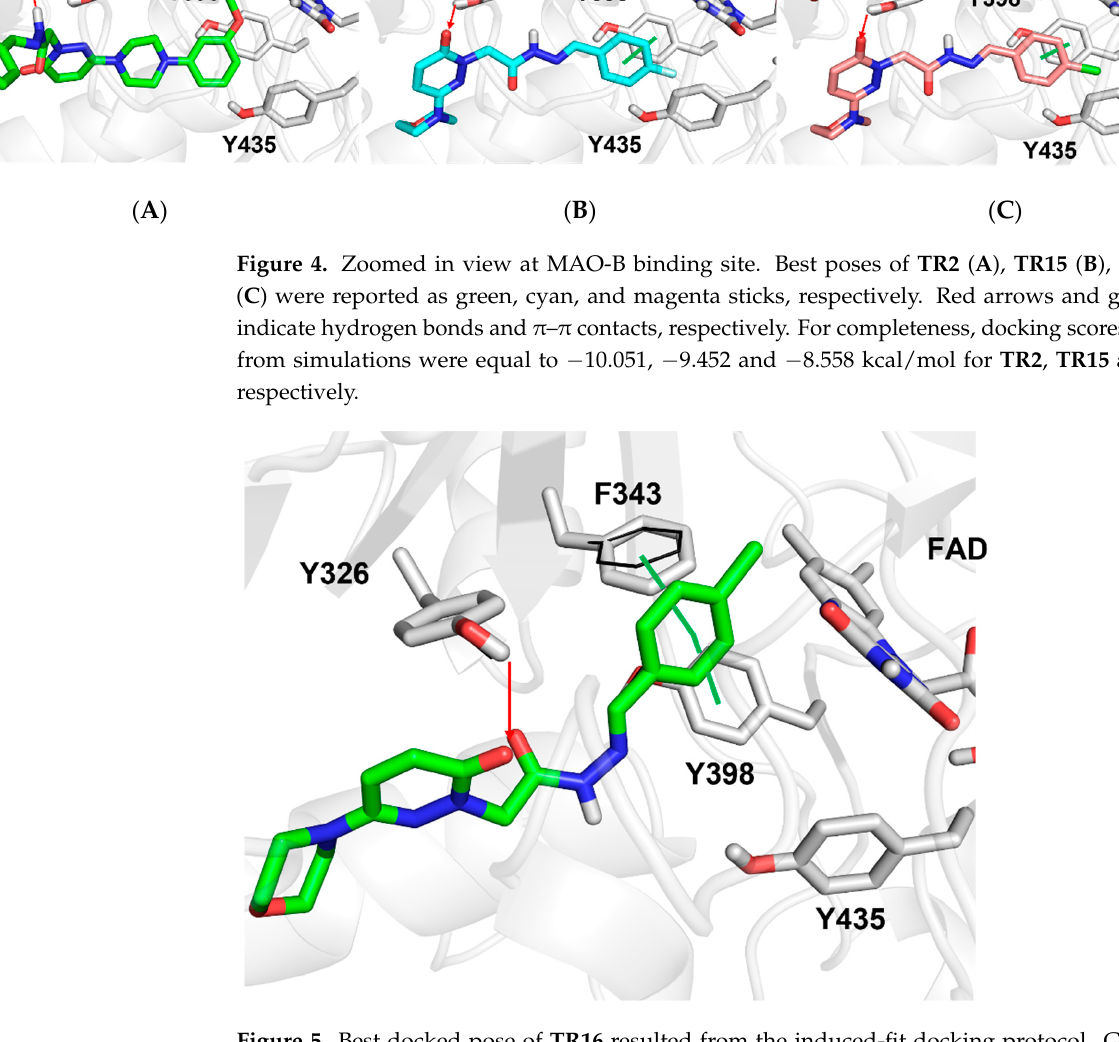
Figure 5. Best docked pose of TR16 resulted from the induced-fit docking protocol. Green lines and red arrows depict π – π contacts and hydrogen bonds, respectively. Black lines show the original conformation of MAO-B sidechains. For completeness, docking score was equal to − 11.544 kcal/mol.